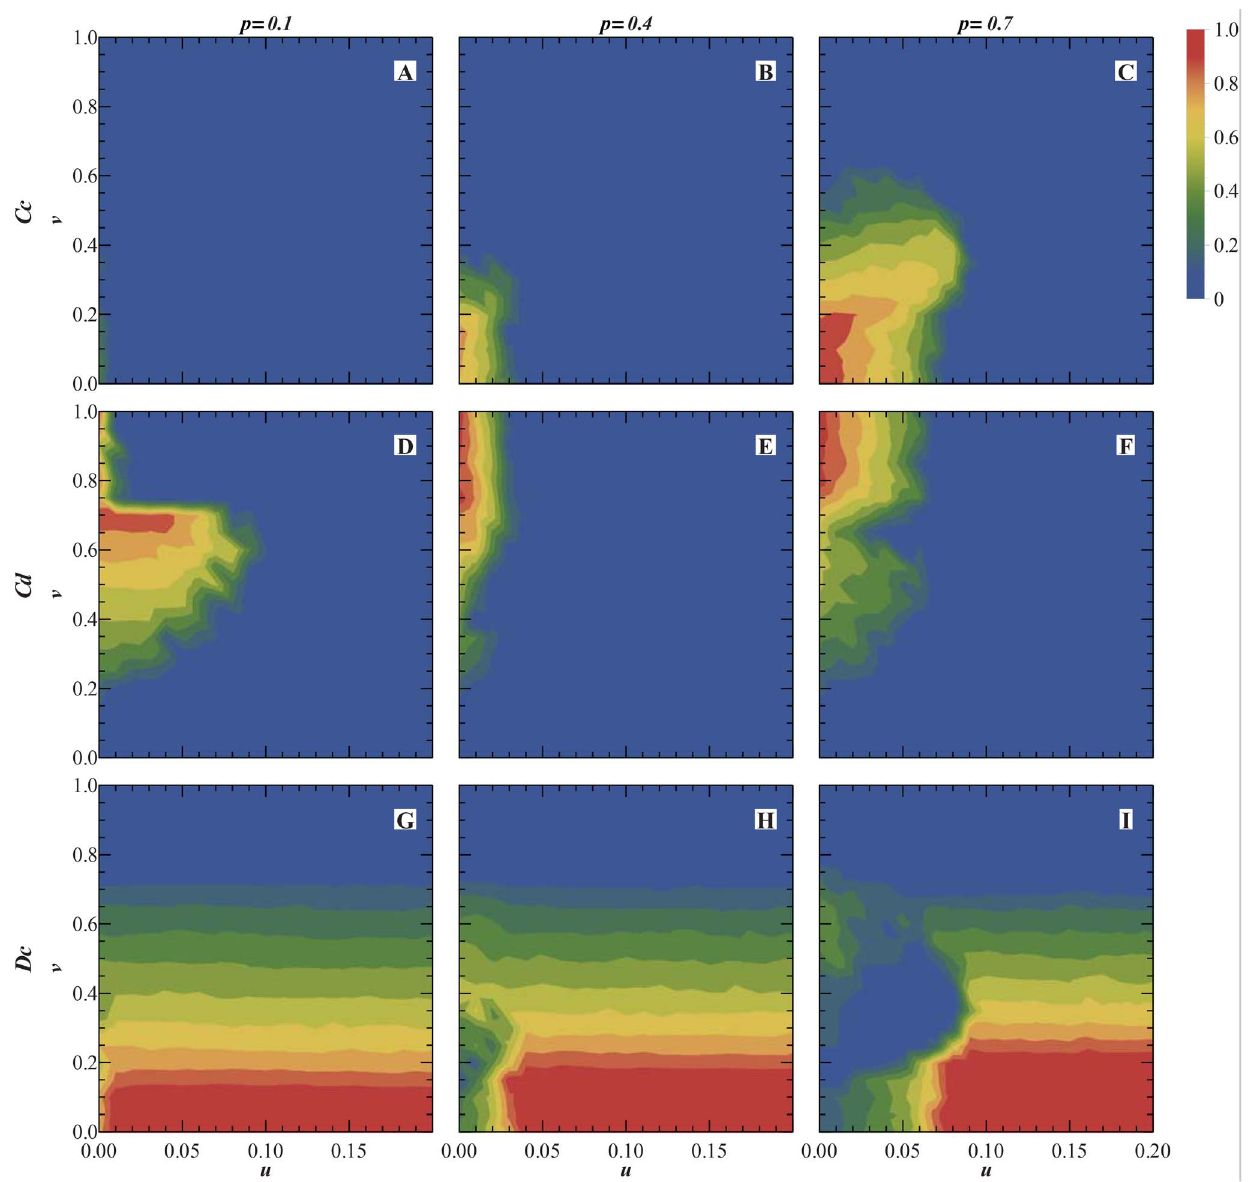
Figure 7. The fractions of Cc (the first row), Cd (the second row) and Dc (the third row) individuals in u { v parameter plane. For the first column p=0.1; the second column p=0.4;the third column p=0.7.